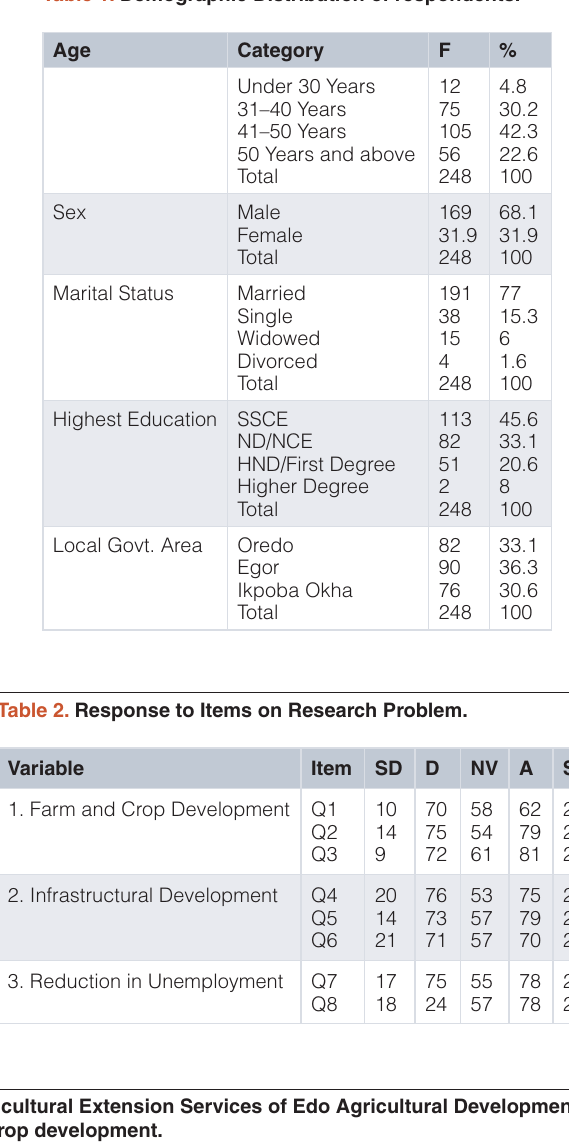
Table 1. Demographic Distribution of respondents.